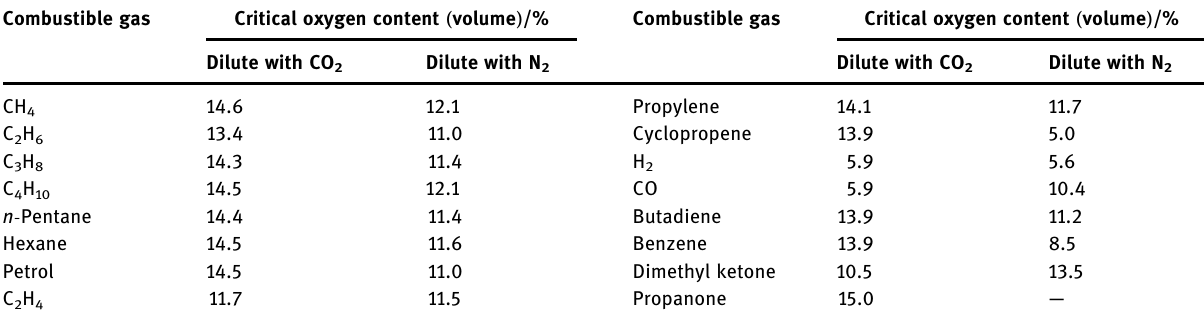
Table 2: Critical oxygen content of some combustible gases Combustible gas